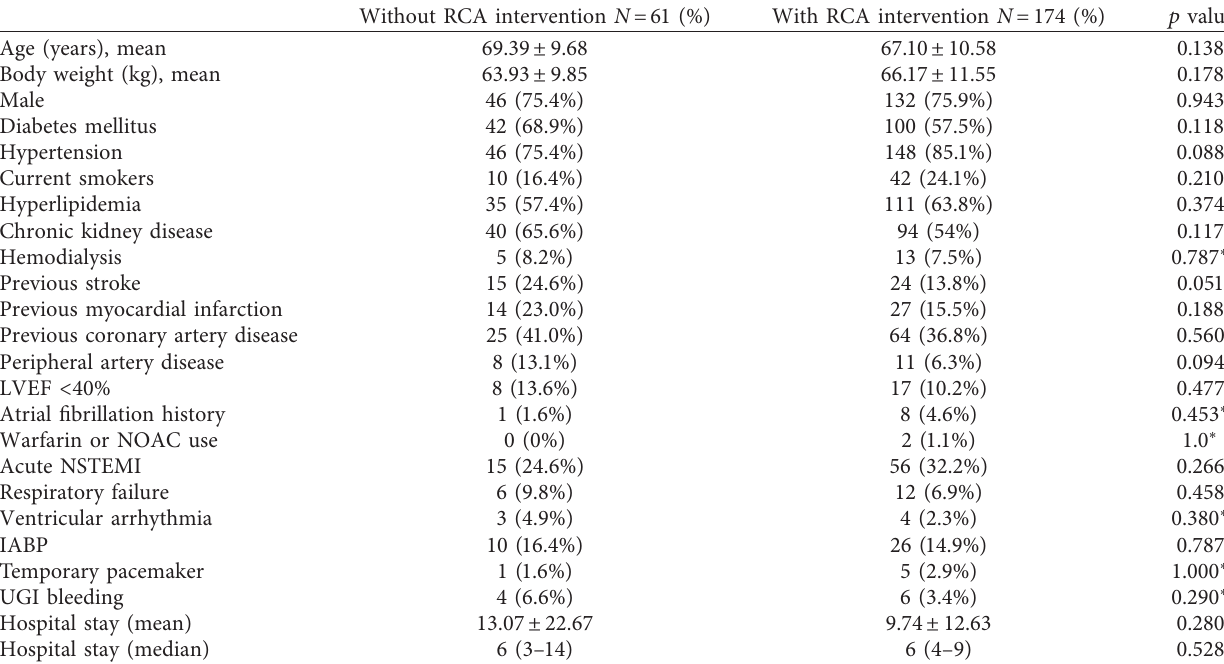
Table 1: Baseline characteristics and clinical status between the two